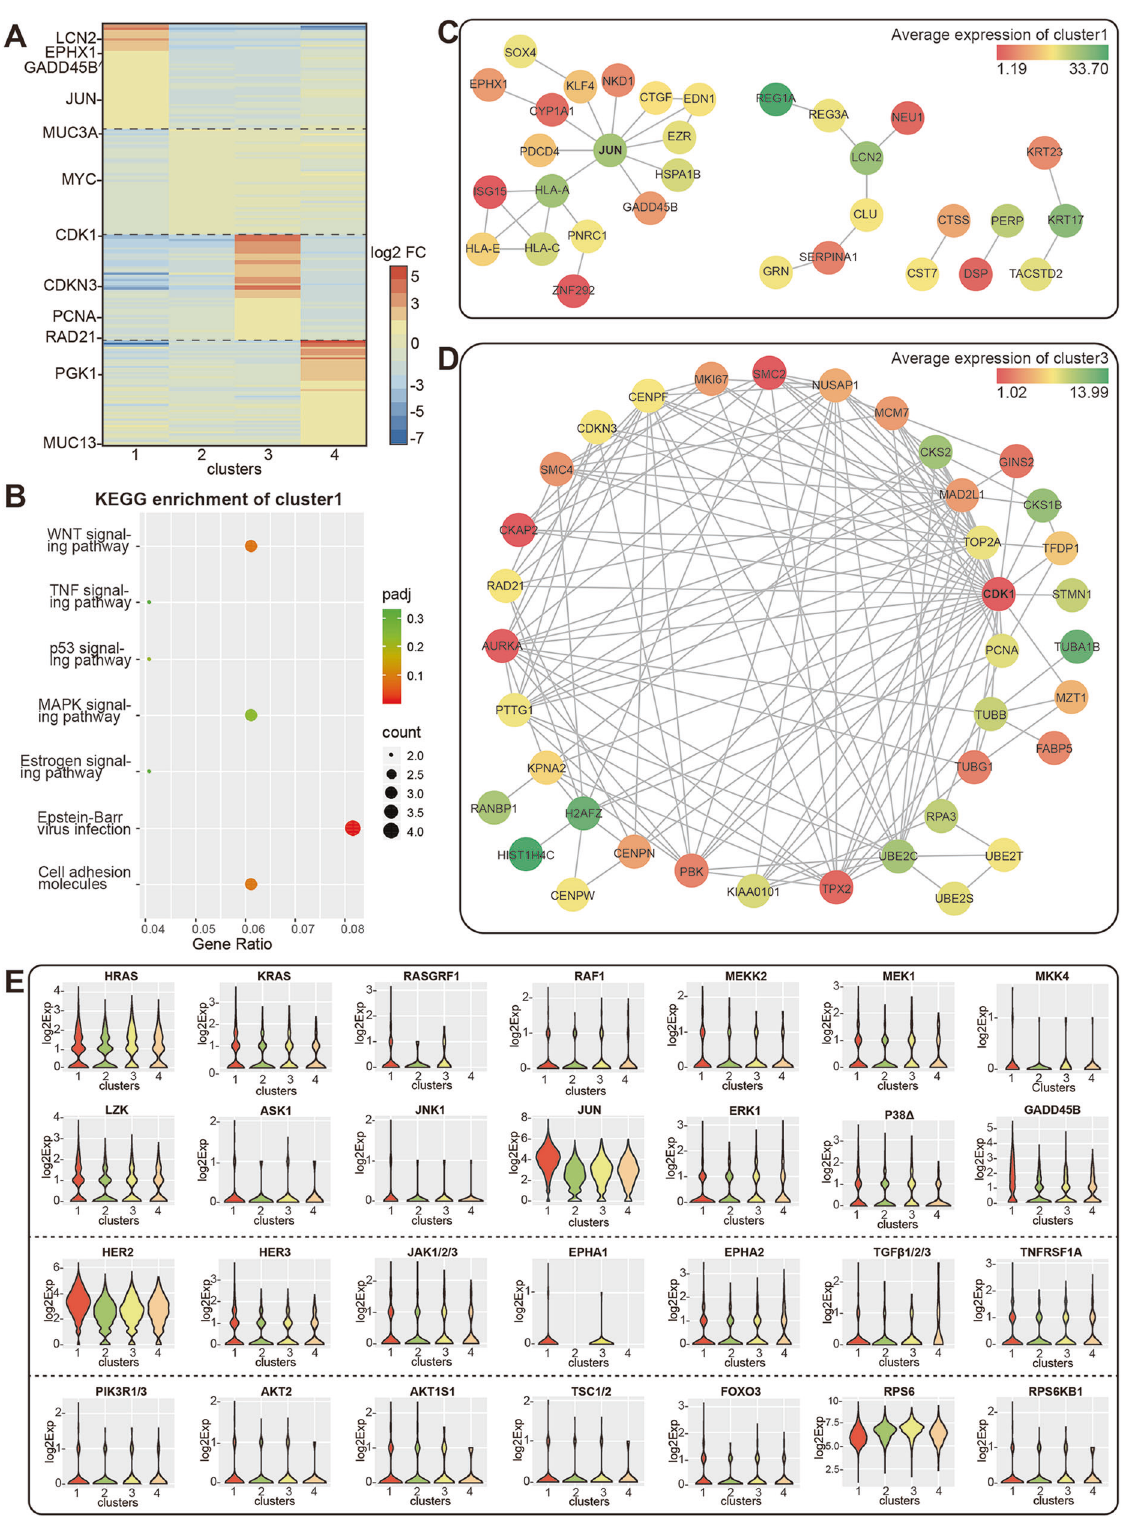
Fig. 3 Intratumoral heterogeneity and differential cell phenotypes in 176P and 176R tissues. A Heatmap showed the top 50 upregulated genes in each cluster. The color bar represented the value of log2 fold change. B The top 50 genes of cluster 1 were enriched by KEGG database. C , D Network diagrams of the top 50 genes of cluster 1 (con fi dence Score = 0.400) and cluster 3 (con fi dence score = 0.900) according to STRING database. The color bar represented the average expression of genes in each cluster. E Violin plots showed the expression pro fi le of some critical molecules that were involved in membrane receptor tyrosine kinase, MAPK, PI3K/AKT signaling pathways in four clusters.